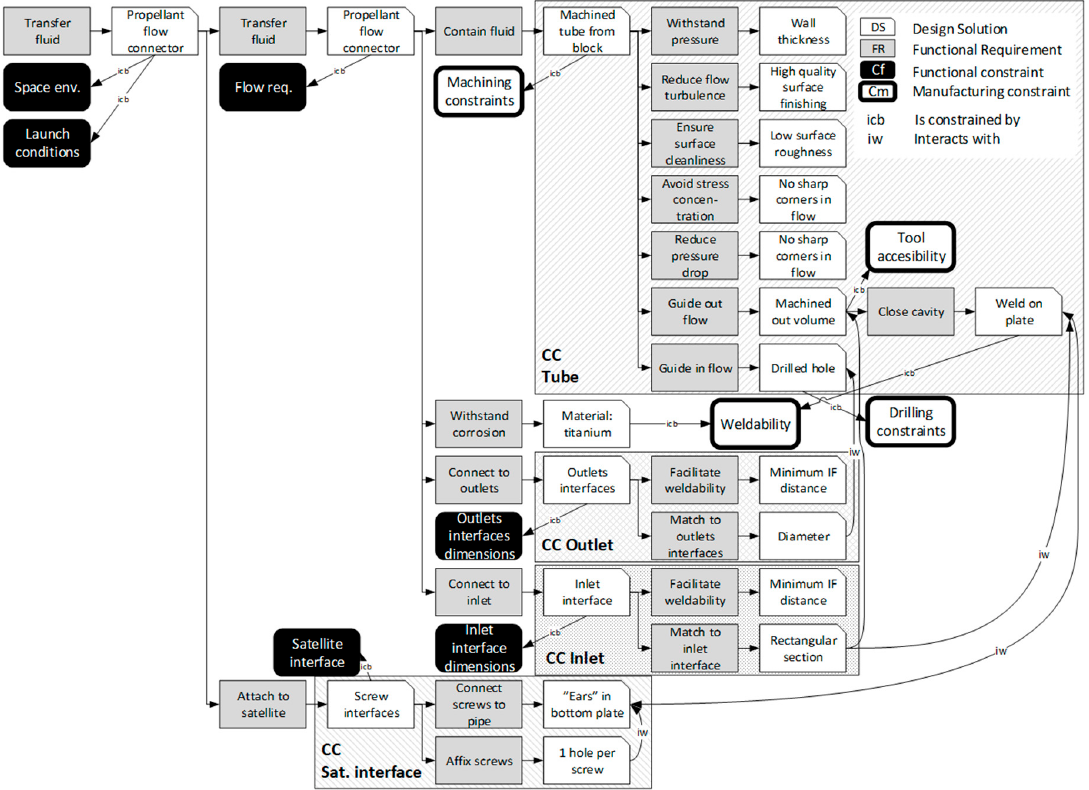
Figure 3. Functional decomposition of the propellant flow connector. The “iw” and “ipmb” connectors were only modeled to the extent needed for the demonstration to keep the graph readable.